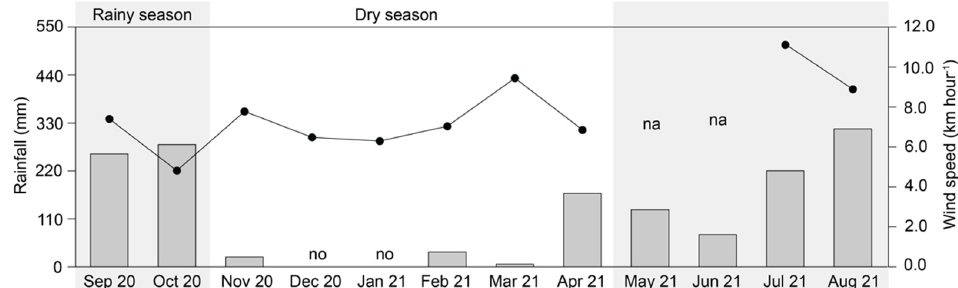
Figure 2. Climatic characteristics obtained from the Samut Prakan (Bang Pla) weather station, including monthly rainfall (bar graph) and wind speed (line graph) from September 2020 to August 2021 (Meteorological Department of Thailand); ‘no’ indicates no rainfall, and ‘na’ indicates no record.